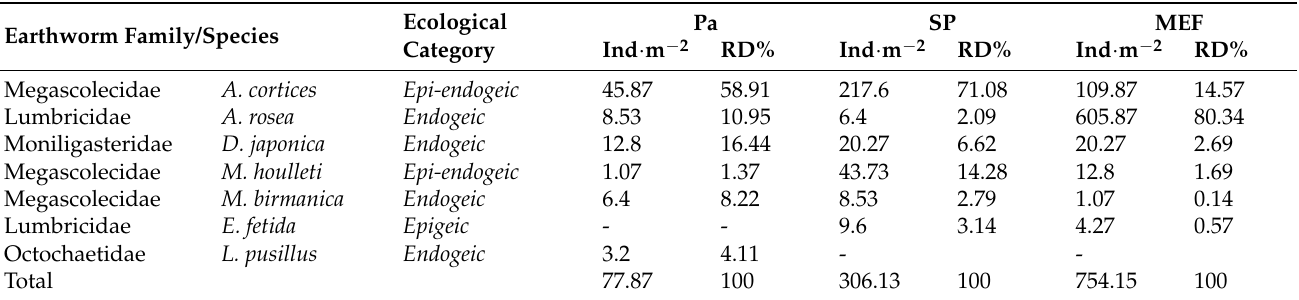
Table 9. The density (ind · m − 2 ) and relative density (RD%) of earthworm species in different land use